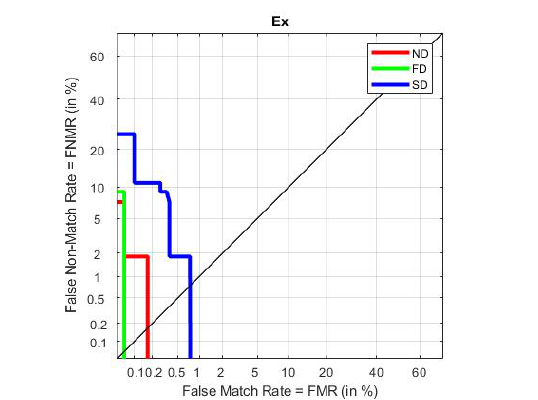
Figure 5. Detection Error Trade-off (DET) for Ex as train and test